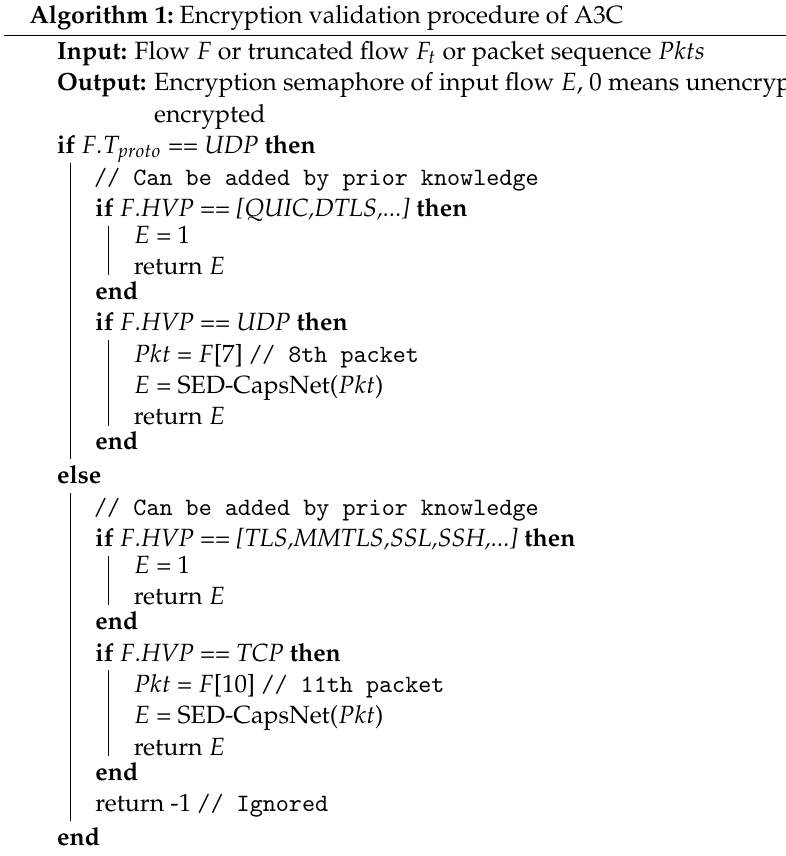
Algorithm 1: Encryption validation procedure of A3C